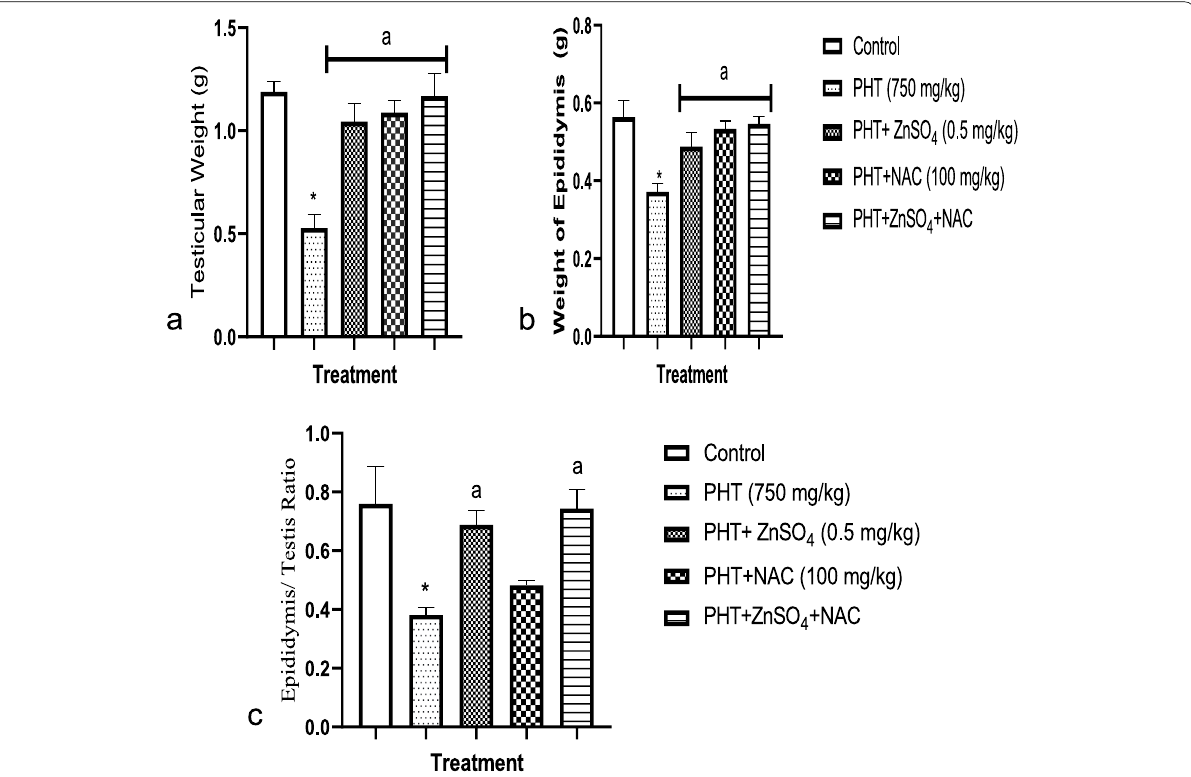
Fig. 1 Effects of treatment with zinc sulfate and N‑acetylcysteine on organ weight in phthalate‑treated male Wistar rats. Values are expressed as mean SEM ( n 5) (one‑way ANOVA followed by Tukey’s post hoc test). PHT phthalate, ZnSO 4 zinc sulfate, NAC N‑acetylcysteine. * and a p < 0.05 ± = were considered statistically significant when compared with the control and PHT‑treated groups